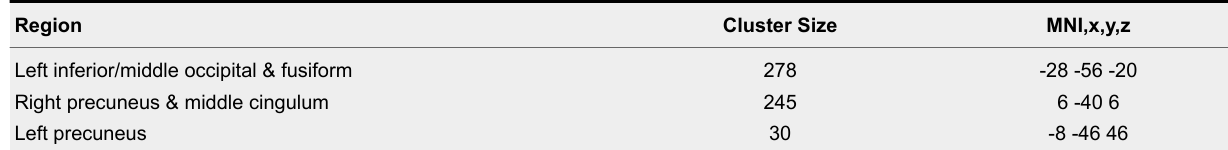
Common Regions for Negatively Correlating With Finger Sense for Addition and Subtraction Region